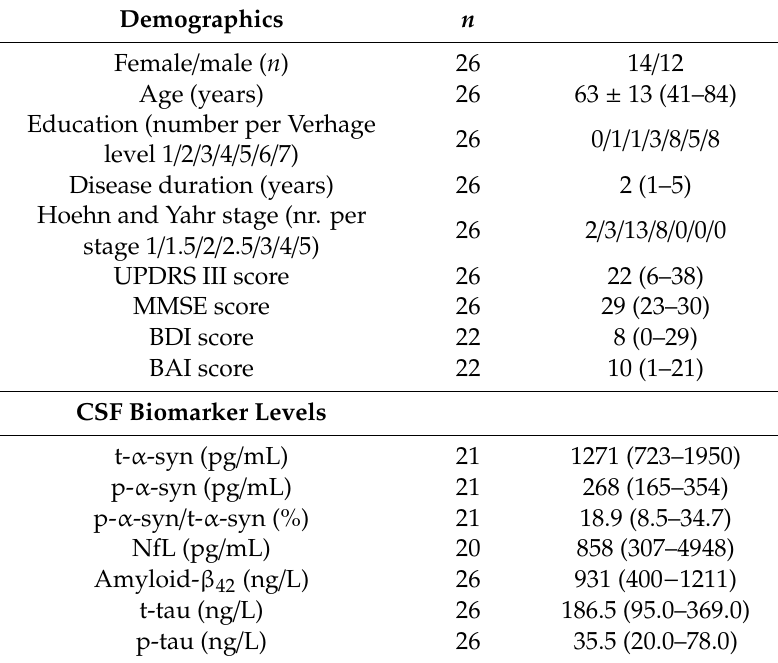
Table 1. Demographic data and cerebrospinal fluid concentrations in patients with early-stage Parkinson (cid:48) s